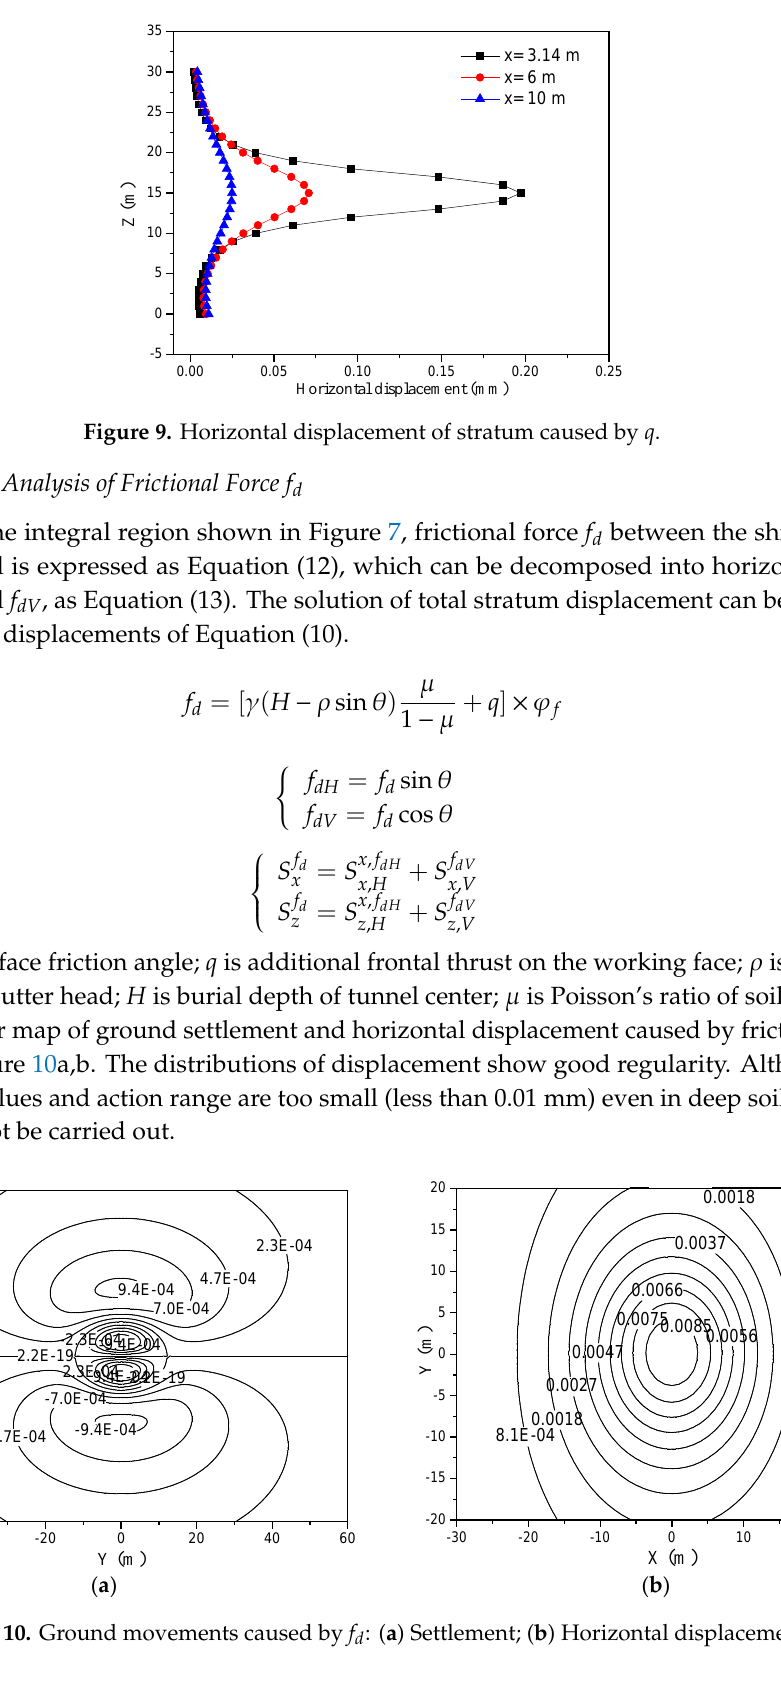
Figure 8. Longitudinal ground settlement caused by q .